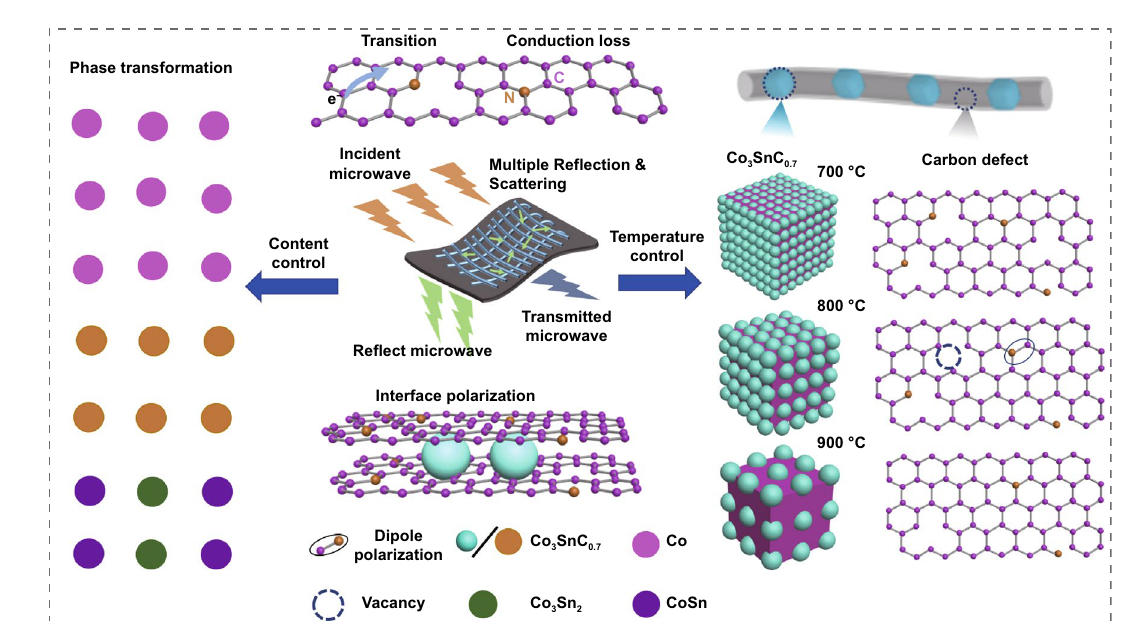
Fig. 10 Schematic illustration revealing the mechanisms involved of the EMW wave absorption for the Co 3 SnC 0.7 /CNF